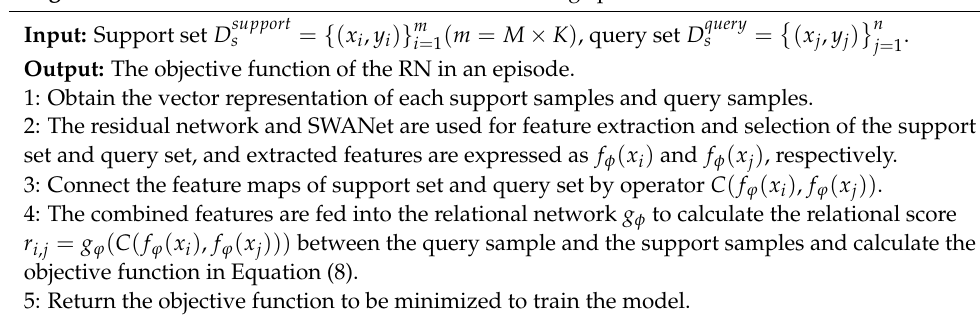
Algorithm 1. Framework of the 3D-ARRN for a training episode